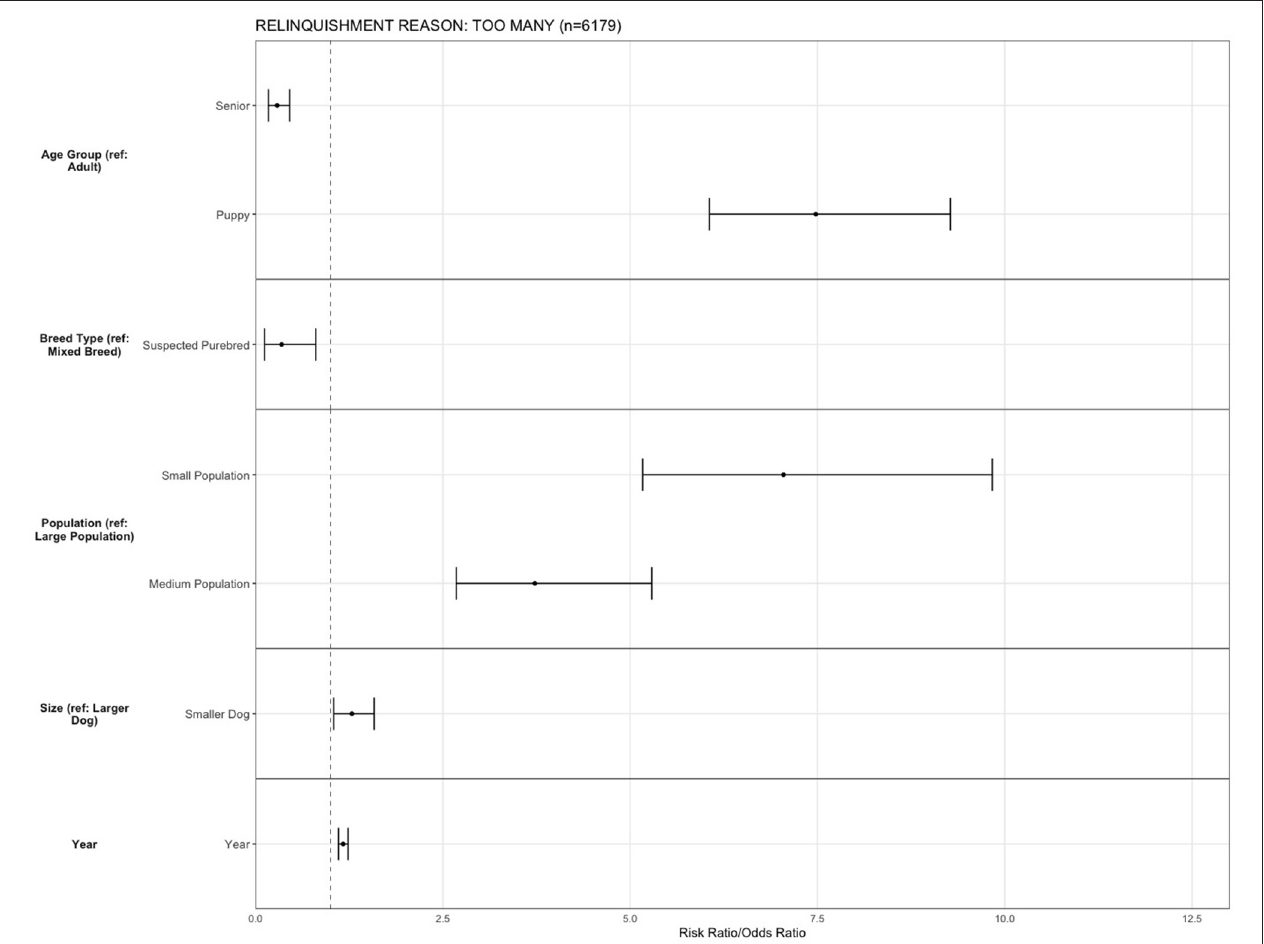
FIGURE 4 | The association between relinquishment reason and characteristics for puppy and adult dogs relinquished by guardians for the reason of “too many” ( n = 6,179). Characteristics include age group, Asilomar Accords category, breed type, dog size, sex, population center size, and year. The results of the logistic regression model are shown. Data are presented by risk ratios and their 95% confidence interval (bars); p < 0.05 when 95% confidence interval does not cross the vertical dotted line. A risk ratio > 1 suggests an increased risk of relinquishment of that the characteristic category, while a risk ratio < 1 suggests a reduced risk. Non-statistically significant results are excluded from the